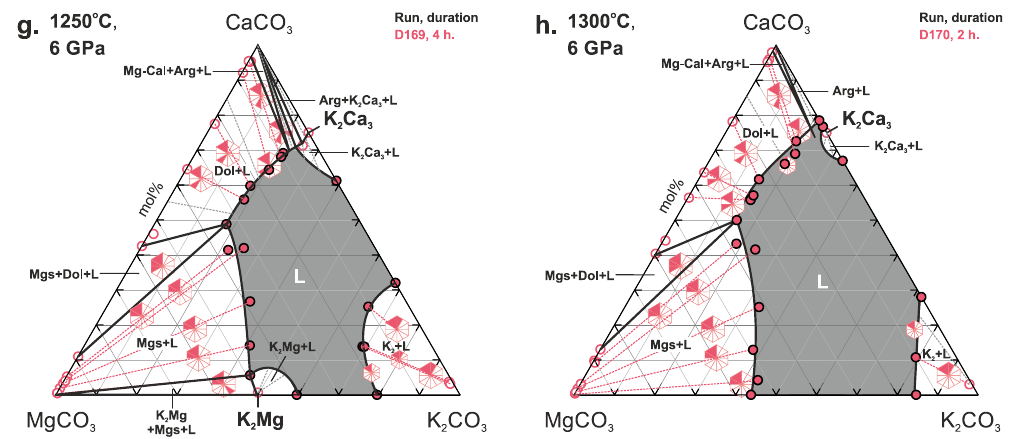
Figure 5. Isothermal sections of the K 2 CO 3 – MgCO 3 – CaCO 3 T-X diagram at 6 GPa. ( a ) 900 °C, ( b ) 1000 °C, ( c ) ~1080 °C, ( d ) 1080 < T < 1100 °C (inferred), ( e ) 1100 °C, ( f ) 1200 °C, ( g ) 1250 °C, ( h ) 1300 °C. K 2 = K 2 CO 3 , K 8 Ca 3 = K 8 Ca 3 (CO 3 ) 7 (Ca# ≥ 97), K 2 Ca = K 2 (Ca,Mg)(CO 3 ) 2 (Ca# ≥ 51), K 2 Ca 3 = K 2 Ca 3 (CO 3 ) 4 (Ca# ≥ 93), K 2 Mg = K 2 Mg(CO 3 ) 2 (Ca# ≤ 42), Arg = aragonite, Ca-Dol = Ca-rich dolomite, Dol = dolomite, Mg-Cal = Mg-bearing calcite, Mgs = magnesite, L = liquid. Colored marks denote different runs shown in the upper-right corner of each isothermal section. Open and filled circles indicate the compositions of solid and liquid phases measured by EDS. Filled segments in hexagons denote phases present. Yellow segments indicate the phases appearing in the LT side.